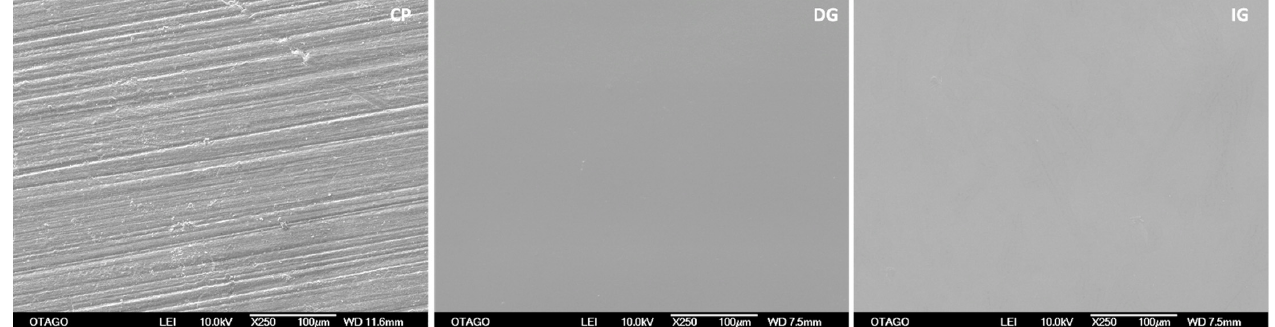
Figure 2. Typical Stress/Strain plot for a specimen.